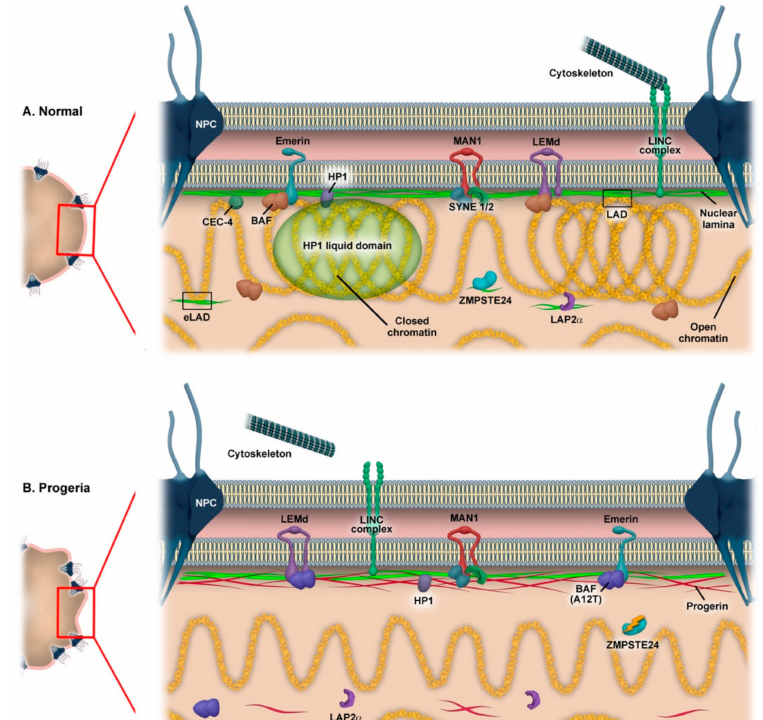
Figure 1. Schematic comparison of normal (( A ) top) and progeria (( B ) bottom) nuclei. In normal cells, repressed lamina-associated domains (LADs) accumulate at the nuclear periphery although lamin proteins also interact with euchromatin (eLAD). Other examples of nuclear envelope proteins involved in chromatin organization include BAF and chromodomain proteins, such as CEC-4 and HP1. The latter also promotes segregation of chromatin through phase separation. Linker of nucleoskeleton and cytoskeleton (LINC) complexes are responsible for nuclear positioning and transmission of mechanostimuli to the nucleus via the nuclear lamina. Other proteins are described in the main text. In progeroid cells, incorrect processing of lamin A (due to mutations in LMNA or ZMPSTE24 ) leads to accumulation of progerin, alterations in the structure of the nuclear lamina, and detachment of chromatin. Mutation in BAF can also lead to progeria, presumably through perturbation of BAF interaction with chromatin and / or lamins. Changes in nuclear morphology are frequently observed in cells from progeria patients. Moreover, reduced methylation of heterochromatin impairs contacts with HP1 and